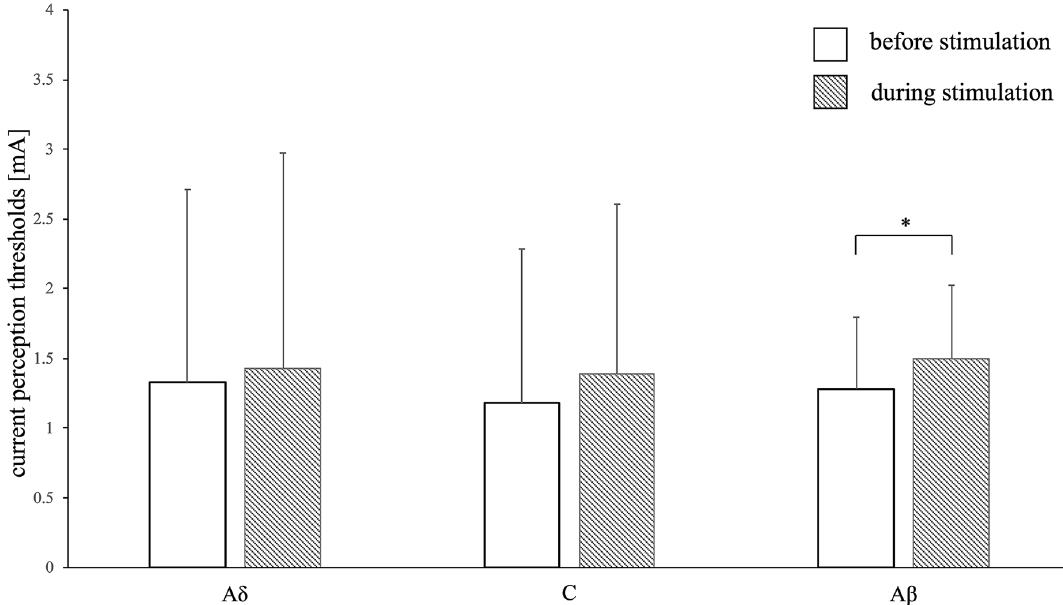
Figure 1. Current perception thresholds under non-noxious condition. Differences in the mean value of current perception thresholds before and after non-noxious stimulation. The error bars indicate standard deviation. No significant changes are observed in the current perception thresholds of the Aδ and C fibers when the dorsal side of the forearm was lightly rubbed with a brush. A significant increase in the threshold of the Aβ fibers is observed. Asterisks represent significant differences (* P <